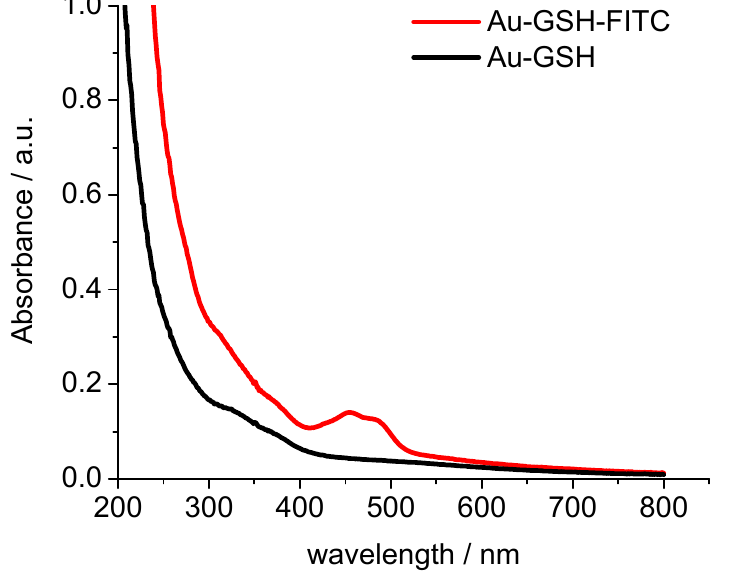
Figure 2. Disc centrifugal sedimentation data (DCS) of Au-GSH nanoparticles.